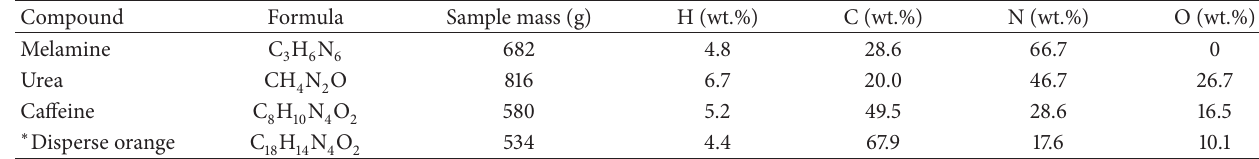
Table 1: Elemental composition of the bulk samples used in present study.